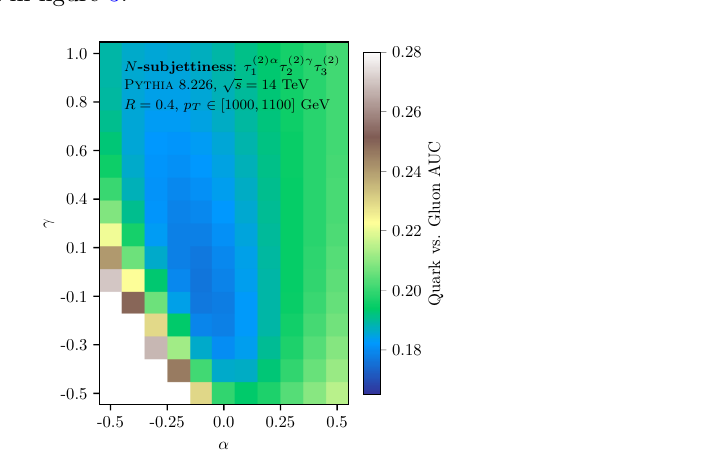
Figure 11. The AUC quark vs. gluon discrimination performance of N -subjettiness product observable = (cid:28) (cid:11) (cid:28) 2 , sweeping over di(cid:11)erent parameter values. We see good qualitative agreement 1 O with the predictions shown in (cid:12)gure 3.